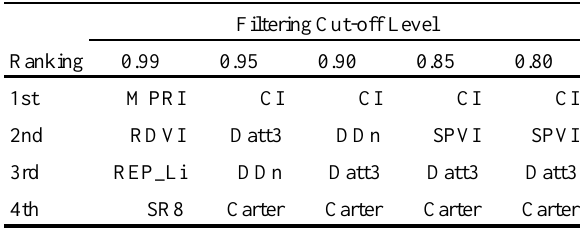
Table 1 - Selected features by different initial correlation cut-off levels.